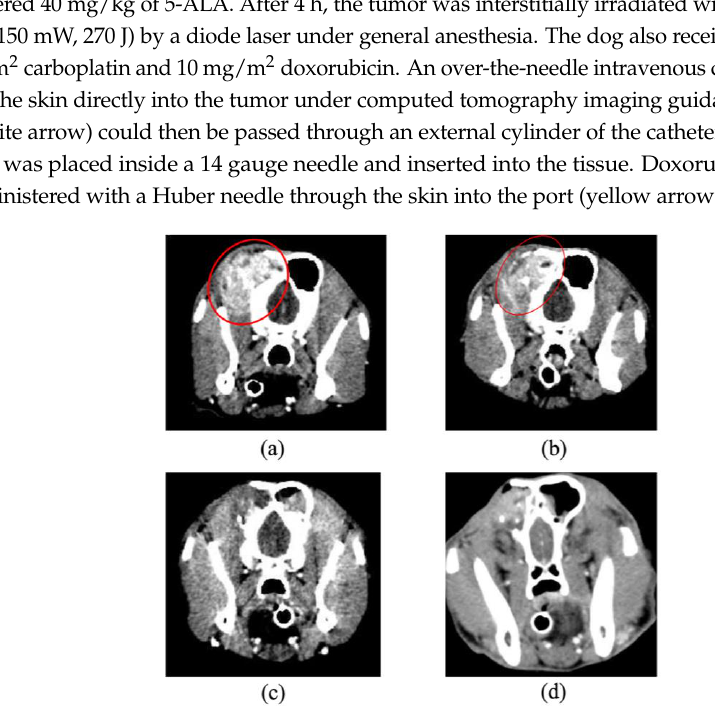
Figure 5. Photodynamic therapy and intra-arterial chemotherapy injection for case No. 11. An 11 year old, mixed-breed dog presented with hematuria and polyuria. The dog was diagnosed with transitional cell carcinoma of the lower urinary tract and treated with photodynamic therapy as in case No. 10 along with intra-arterial chemotherapy. An optical fiber placed in an 8Fr versatile catheter was inserted into the urethra (white arrow). The fiber tip was placed at the tumor site under ultrasound and the tumor was irradiated (150 mW, 270 J) under sedation.